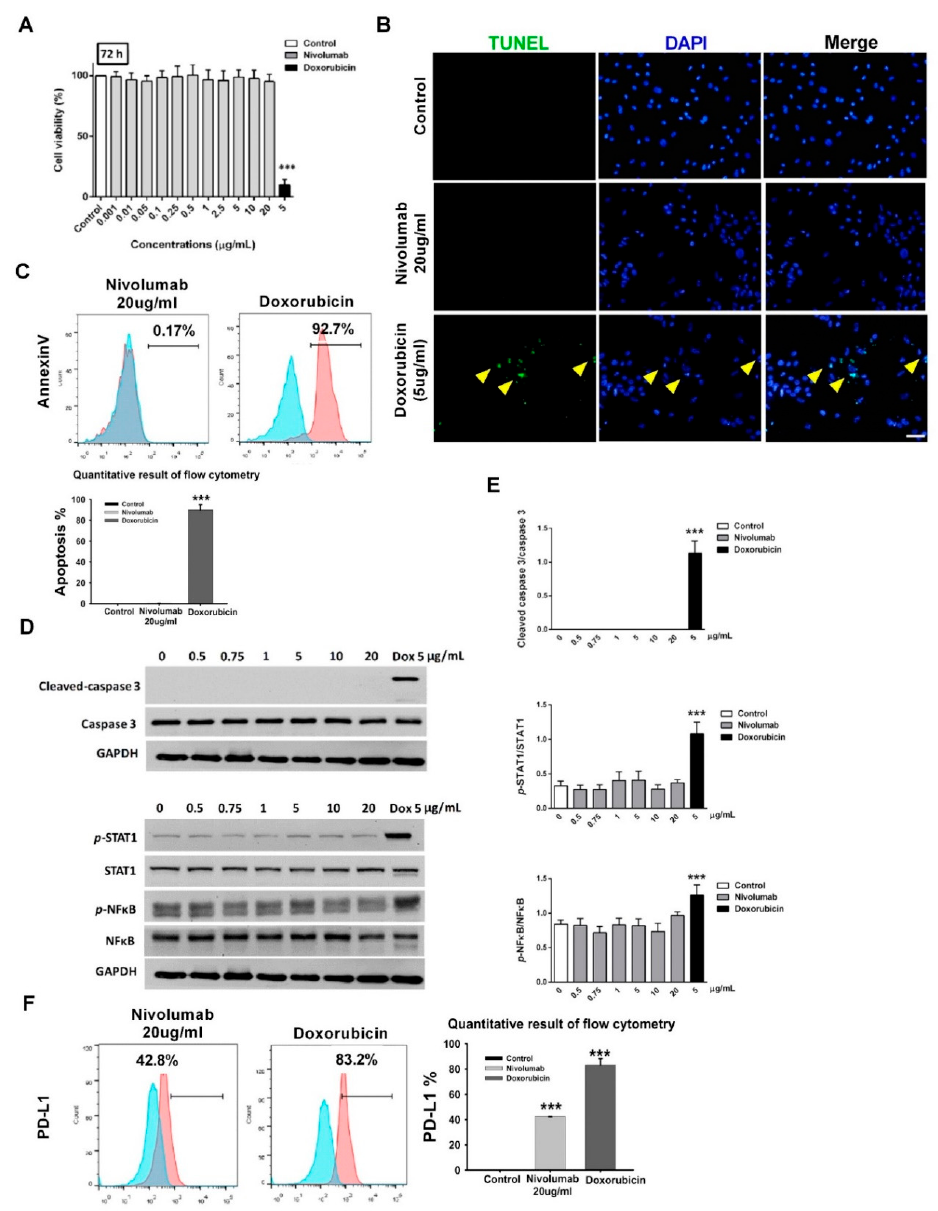
Figure 2. Effects of nivolumab on cell viability in RUES2-CMs. ( A ) The effect of nivolumab on cell viability was determined by an MTT assay. Positive control (doxorubicin 5 µg/mL) was provided. *** p < 0.001 versus control ( n = 3). ( B ) Representative images of the TUNEL staining of cardiomyocytes. TUNEL staining was used to detect cell apoptosis (green). The nuclei were counterstained with DAPI (blue). Cyan color represents TUNEL-positive nuclei on merged photos. Positive control (doxorubicin 5 µg/mL) was provided. Scale bar: 50 µm. ( C ) Representative flow cytometry images of the Annexin V. Positive control (doxorubicin 5 µg/mL) was provided. *** p < 0.001 versus control ( n = 3), one-way ANOVA, posthoc Bonferroni test. ( D ) Representative western blot analysis of caspase3 and inflammation markers—STAT1, NFkB—and the quantitative result ( E ). Positive control (doxorubicin 5 µg/mL) was provided. *** p < 0.001 versus control ( n = 3), one-way ANOVA, posthoc Bonferroni test. Data are shown as the mean ± SD. RUES2-CM, Rockefeller University embryonic stem cell line 2- cardiomyocytes. ( F ) The PD-L1 expression level in RUES2-CMs analyzed by flow cytometry images. The quantitative result is shown in the right panel. *** p < 0.001 versus control ( n = 3), one-way ANOVA, posthoc Bonferroni